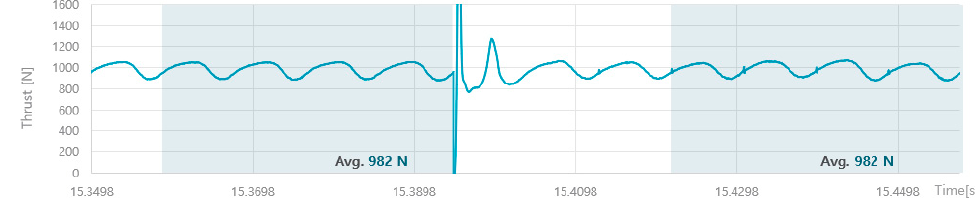
Figure 18. Thrust of composite propeller (model 5) before and after the co-simulation in the cavitating flow.